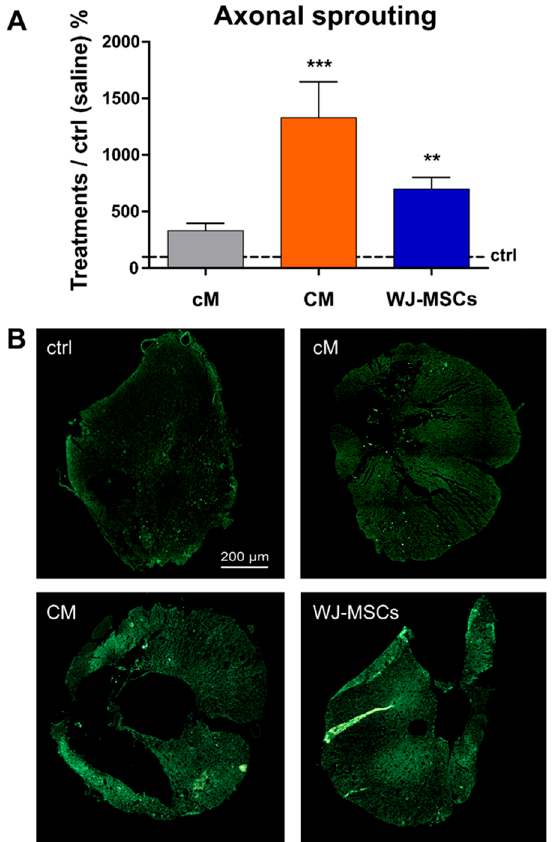
Figure 7. ( A ) The average number of GAP43+ fibers in the treated groups presented as relative when compared to the control (saline), which was set as 100% (depicted with a black interrupted line). Number of animals (five sections per animal): Saline treated control group n = 11, cM group n = 5, CM group n = 9 and WJ-MSCs group n = 7, ** p < 0.01 and *** p < 0.001. ( B ) Representative fluorescent images of GAP43 staining of cross sections 9 weeks after the SCI in the cranial part of the lesion, 5 mm from the